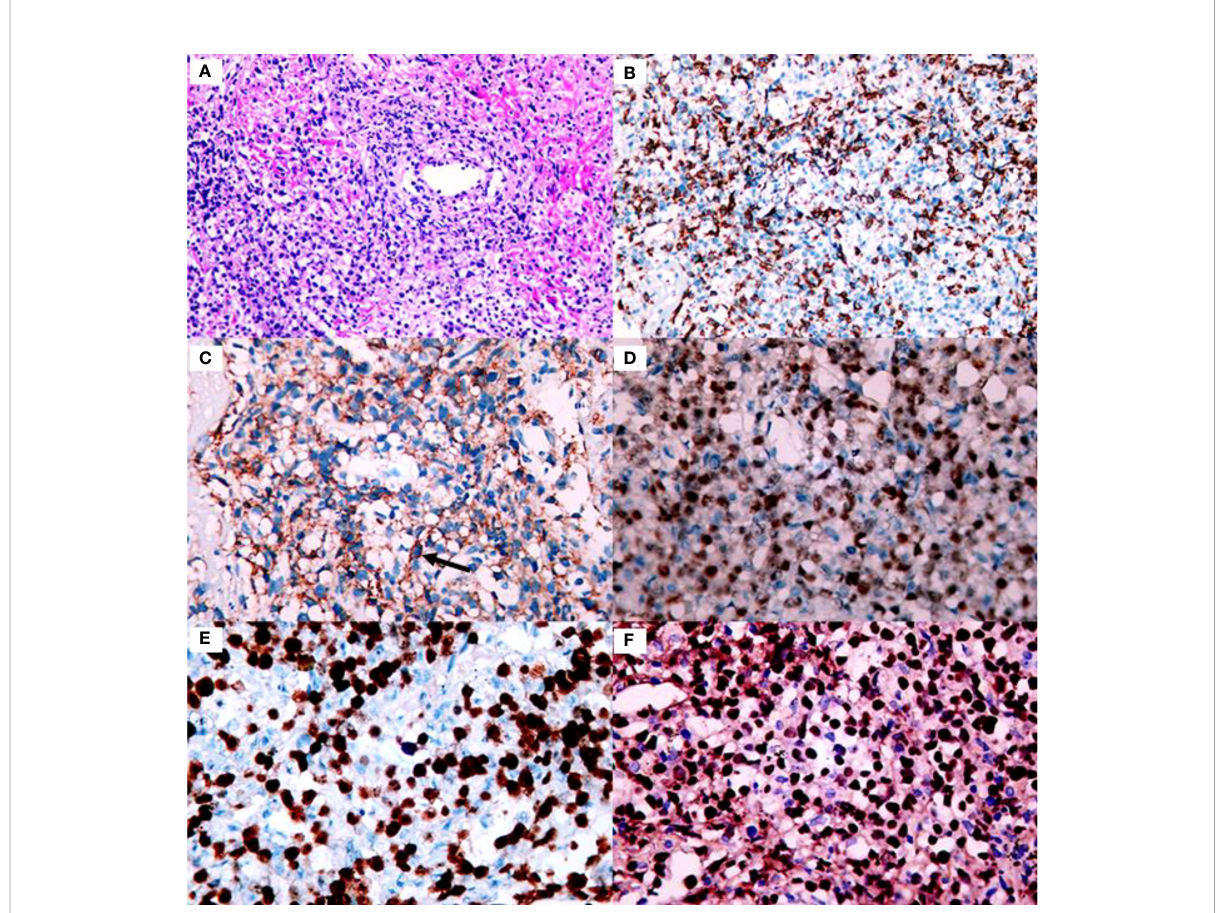
FIGURE 2 Histology and immunohistochemistry of the core biopsy from the lung is consistent with lymphomatoid granulomatosis grade 3. (A) Proliferation and vascular in fi ltration of polymorphic lymphoid cells (×200 magni fi cation). (B) Admixed T cells were positive for CD3 (×200 magni fi cation). (C) Scattered CD20 positive large B-cells are detected-with arrows on the picture (×400 magni fi cation). (D) The large cells are strongly stained with Pax5 (×400 magni fi cation). (E) The large cells are positive for Ki-67 (×400 magni fi cation). (F) The number of EBER positive cells is above 50/HPF consistent with garde 3 lymphomatoid granulomatosis (×400 magni fi